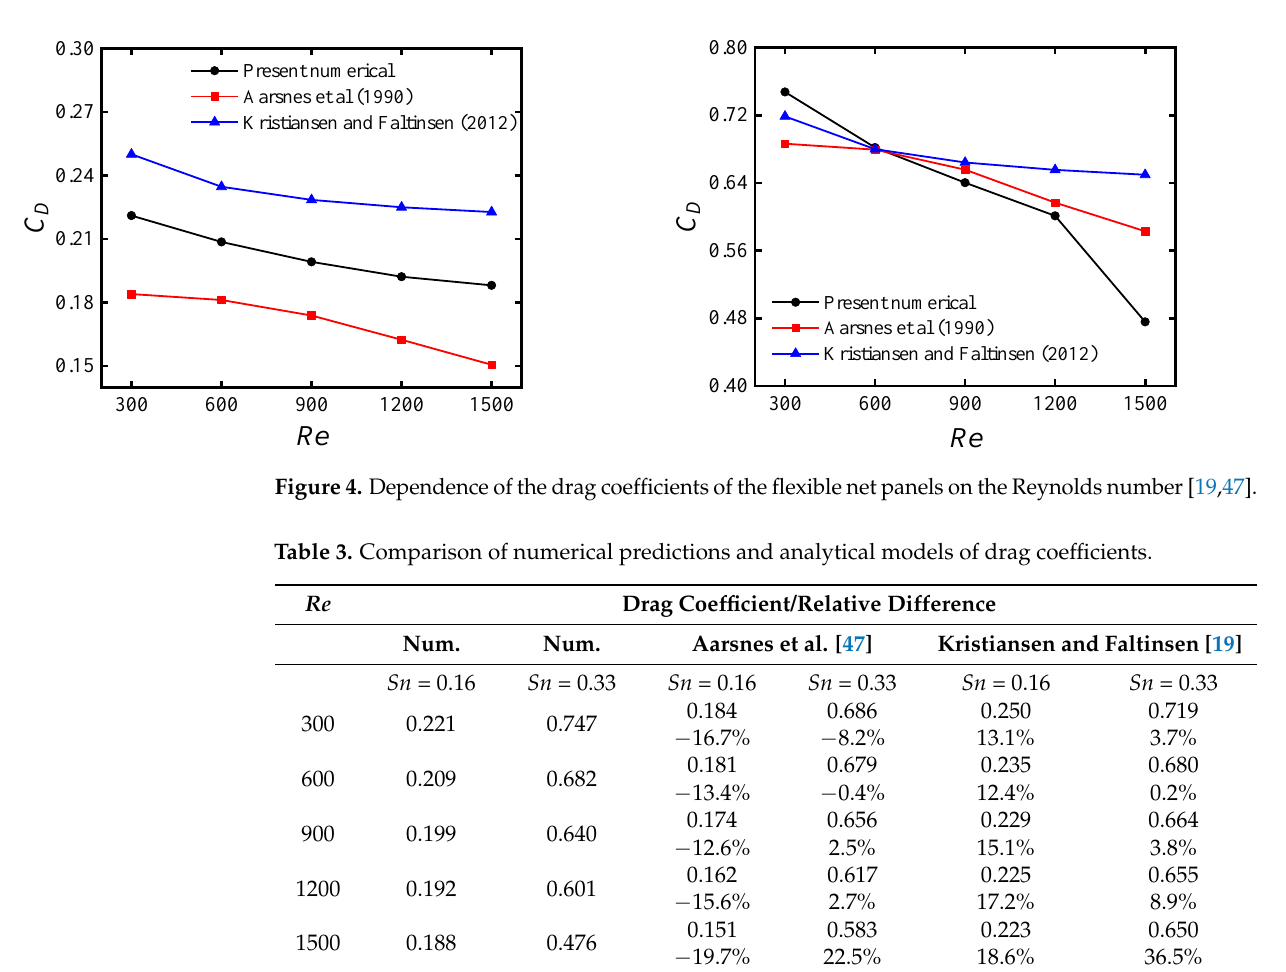
Table 3. Comparison of numerical predictions and analytical models of drag coefficients. 𝑹𝒆 Drag Coefficient/Relative Difference Num. Num. Aarsnes et al. [47]